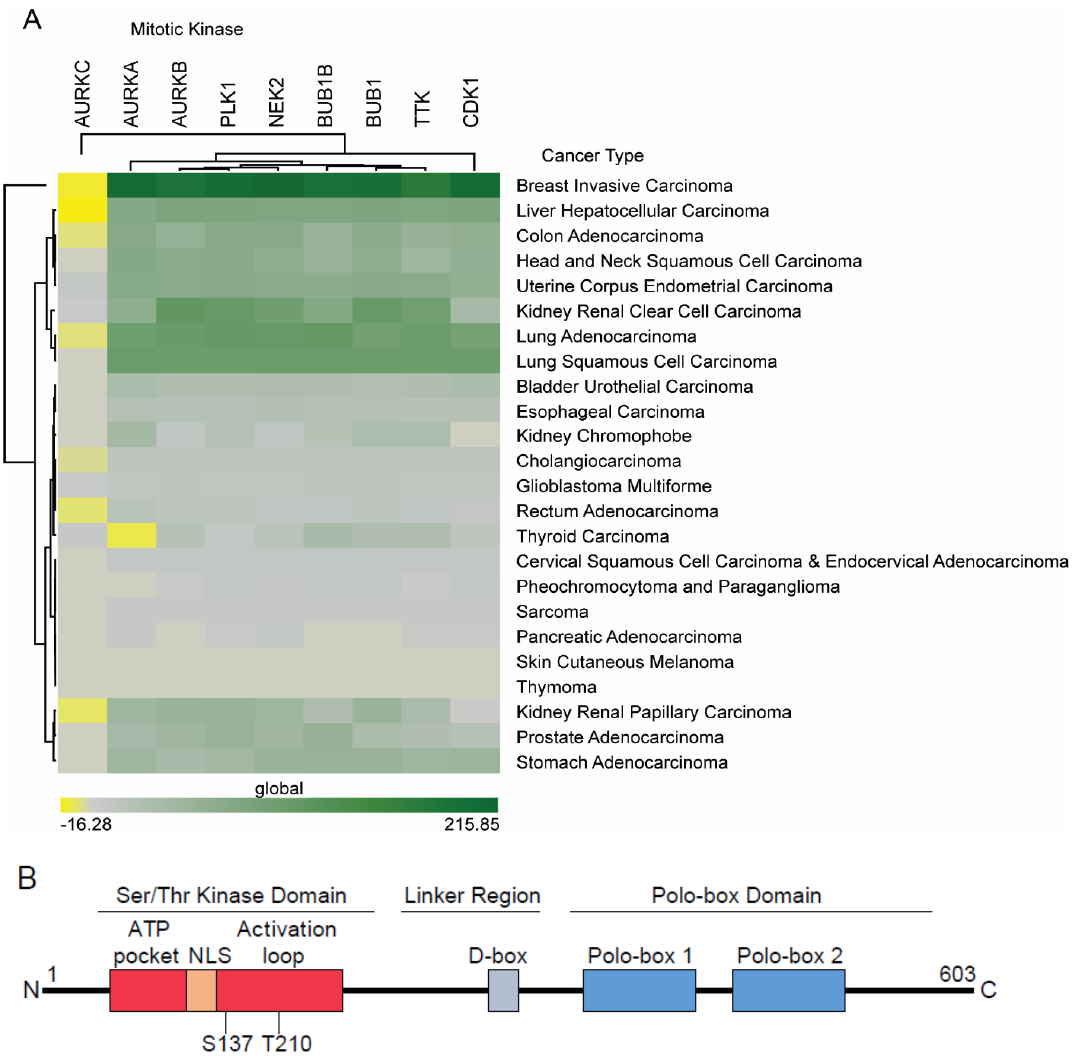
Figure 1. Mitotic kinases that are involved in cancer. ( A ). Differential expression of mitotic kinases across cancer types as analyzed from TCGA data. Green color indicates higher expression in cancer.